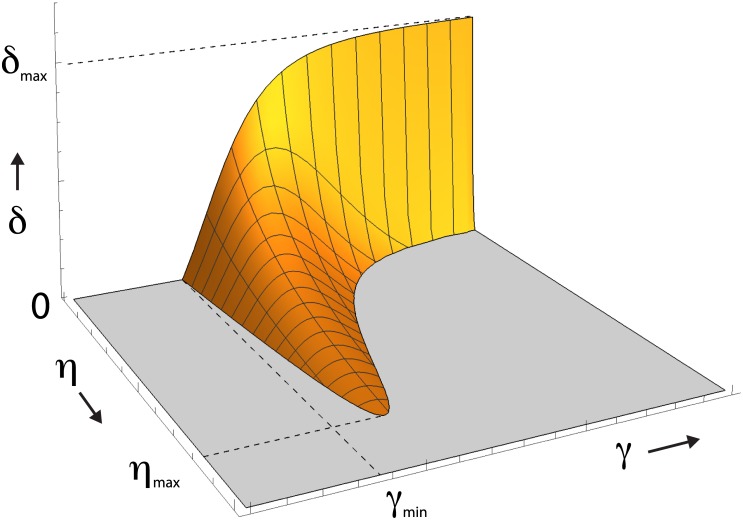
Phase diagram of the model.The polarized state is stable for the region of values of the parameters η, γ and δ enclosed by the depicted boundary surface, for the fixed value of the Hill coefficient p = 5.